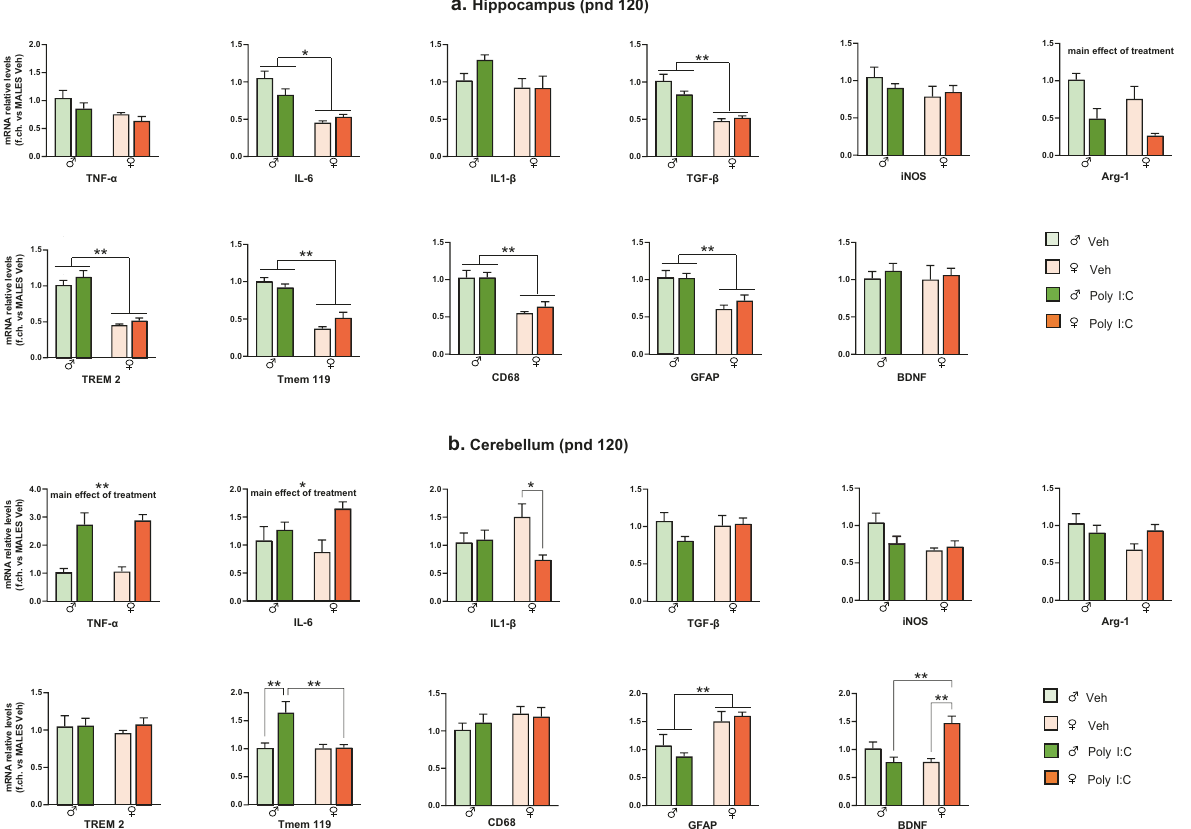
Fig. 3 MIA effect on neuroin fl ammatory pro fi le of PND 120 offspring. mRNA levels in hippocampus ( a ) and cerebellum ( b ) were evaluated by RT-PCR using the 2 − ΔΔ Ct method, normalized to the housekeeping gene β -actin, and relative to Veh males ( n = 6 M/6 F per group). Data